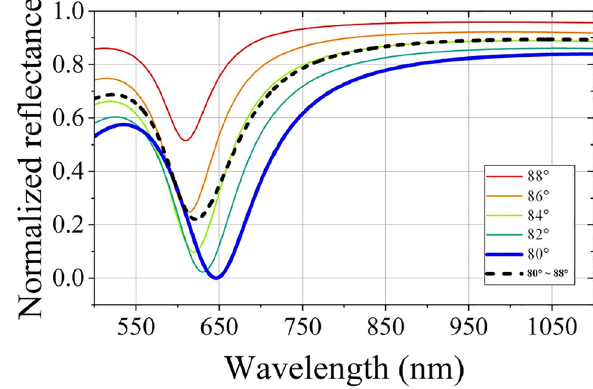
Figure 2: Calculated SPR reflectance spectra at different incident